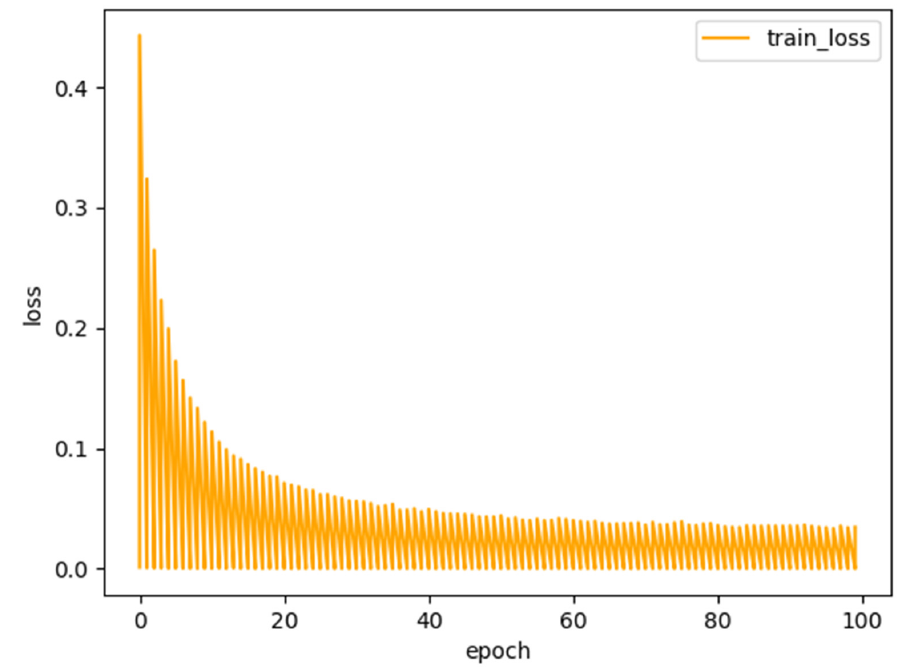
Figure 6. Loss function of the proposed model RDCTrans U-Net.